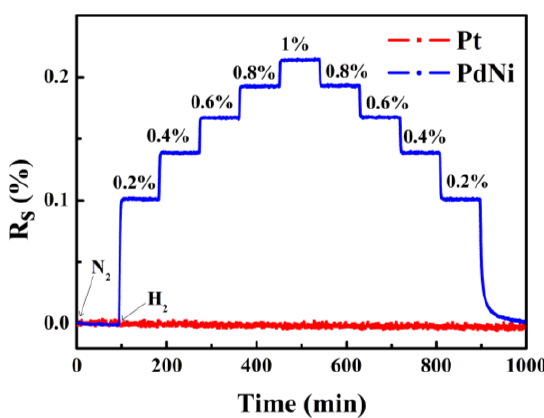
Figure 5. Response curves of the Pt film and PdNi film under various H 2 concentrations.